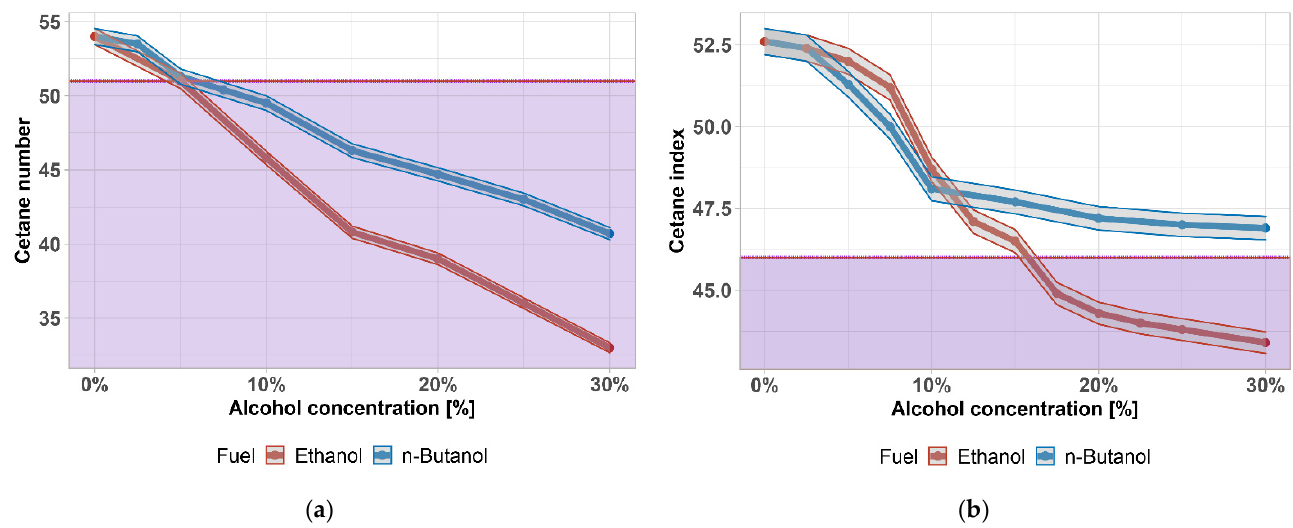
Figure 3. ( a ) Cetane number of diesel fuel–alcohol mixtures; ( b ) cetane index of diesel fuel–alcohol mixtures. Purple area highlights exceeding the limit given by the standard.